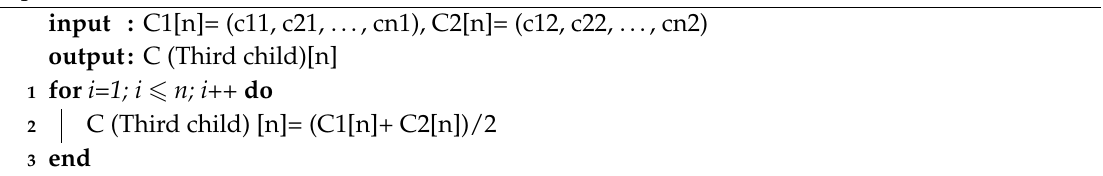
Algorithm 1: Using two n-dimensional arrays (C1, C2) to represent two randomly selected parent